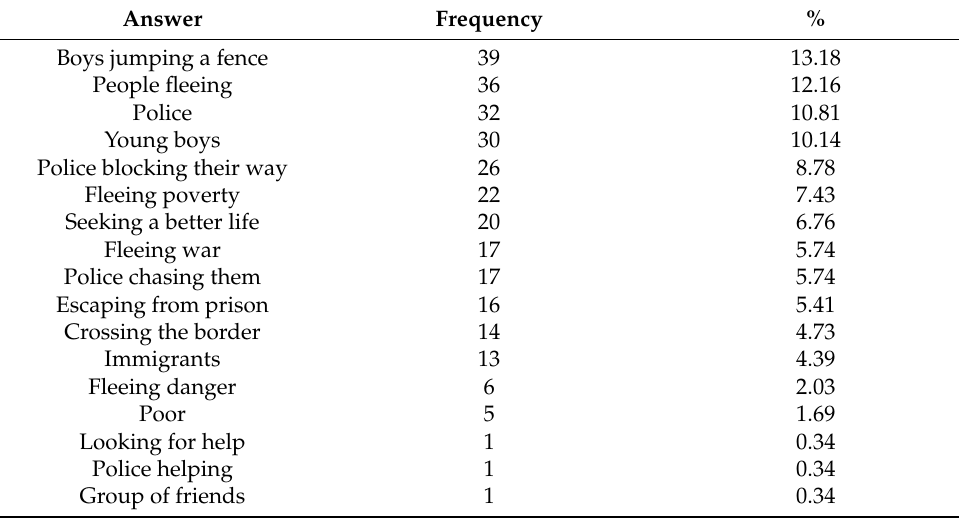
Table 4. Social representations from Figure 2